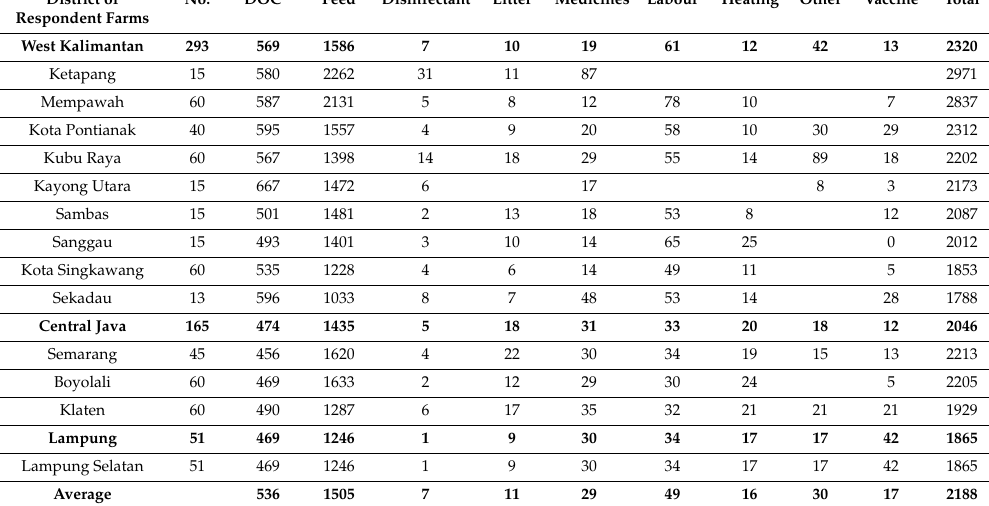
Table 3. Average broiler production costs (United States Dollar (USD) / 1000 birds) at a province and district level. The totals for each province (Central Java, West Kalimantan and Lampung) are shown in bold whilst the districts level data are presented below each